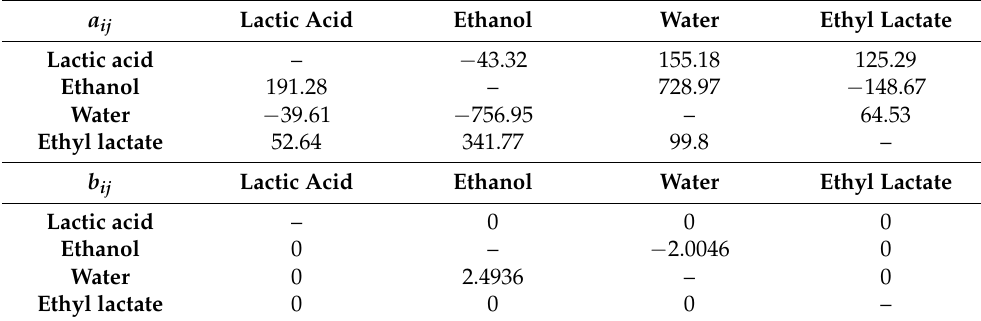
Table A3. UNIQUAC binary interaction